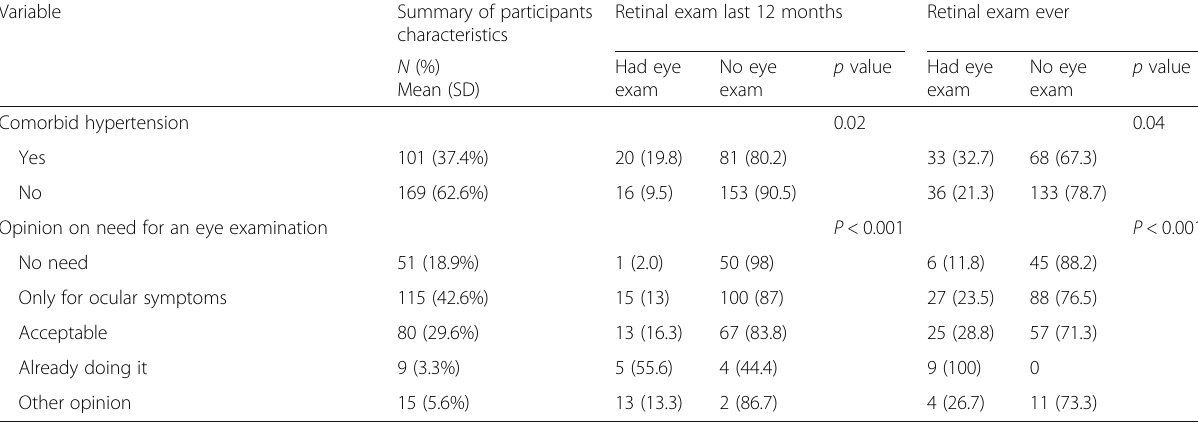
Table 2 Patient characteristics and association with eye examination (Continued)